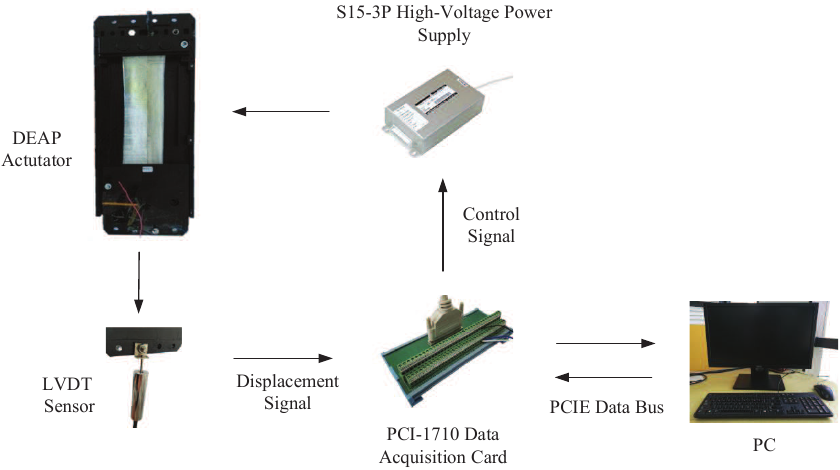
Figure 8. Block diagram of the DEAP